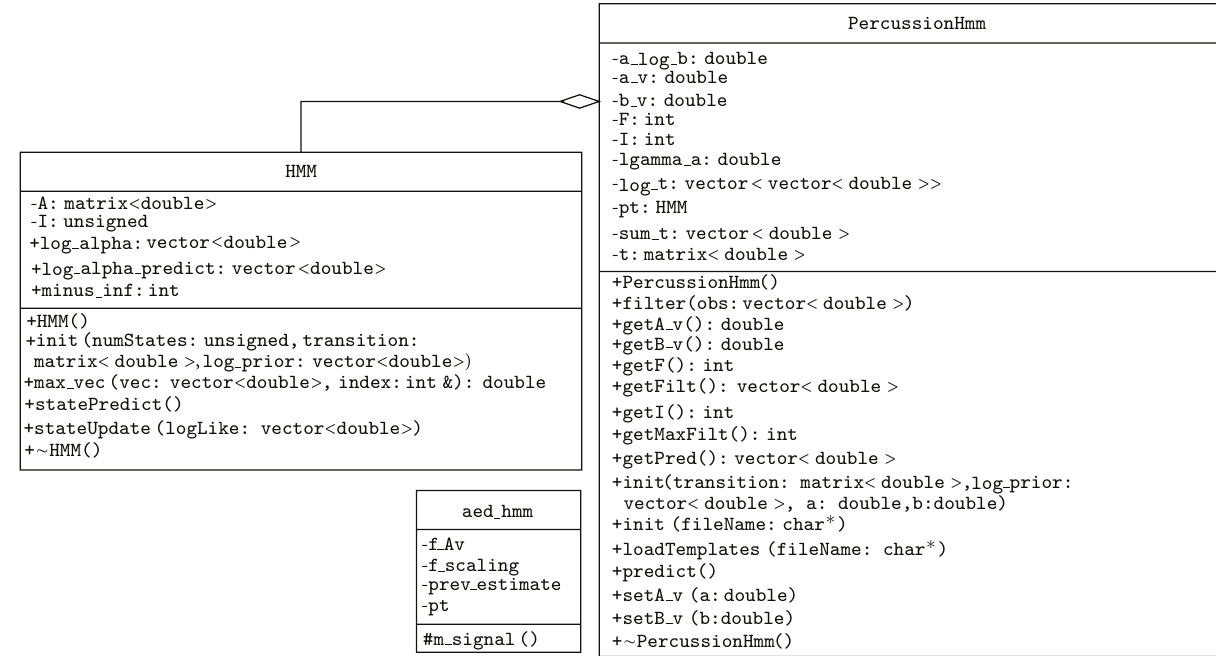
Figure 8: The UML class diagram of the real-time